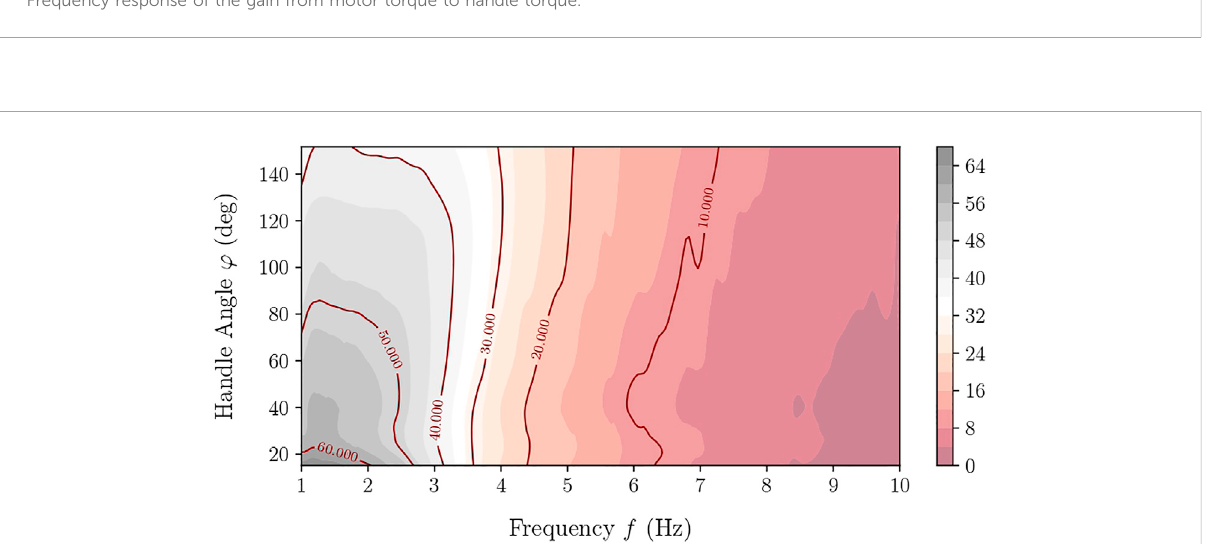
FIGURE 7 Contour plot of the frequency response of the setup for different angles of the